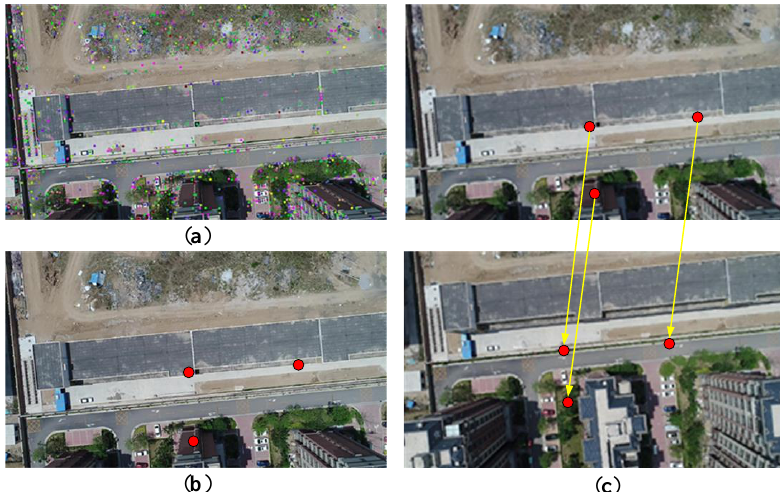
Figure 2. Feature point compression. ( a ) Detecting the feature points of an image; ( b ) calculating the principal component points (PCPs) of the feature points; and ( c ) matching the PCPs.